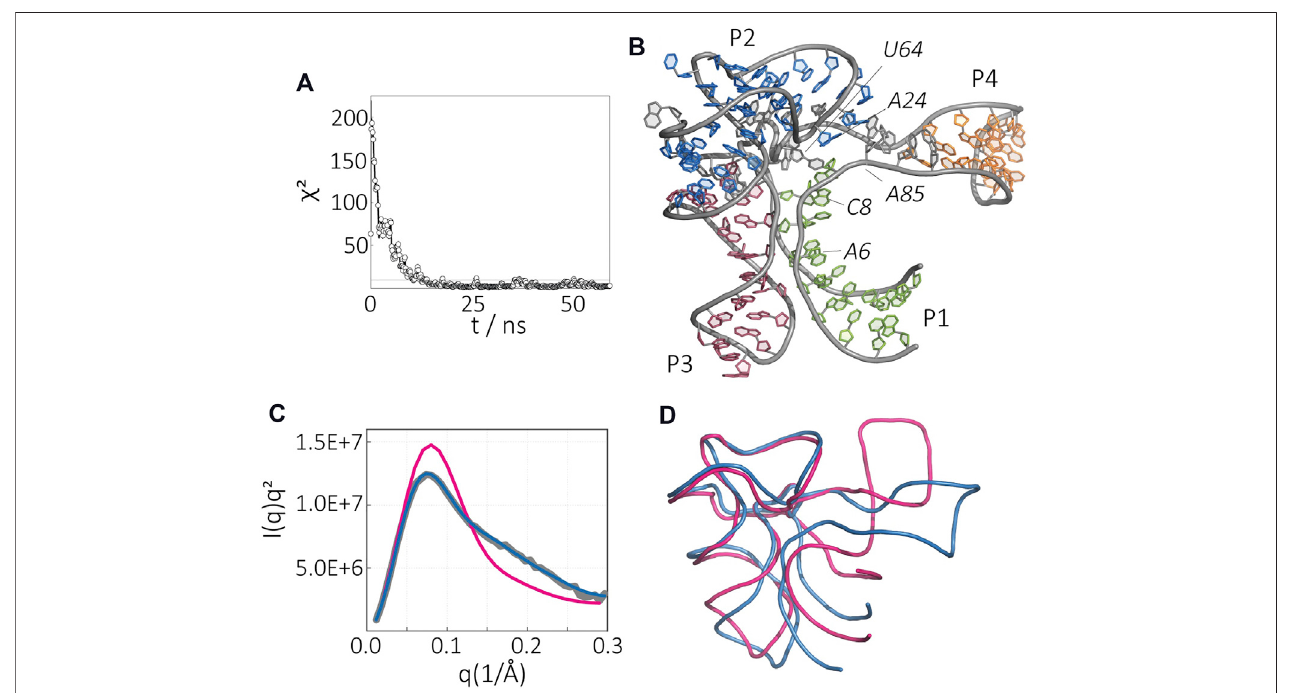
FIGURE 4 | Apo-state of the SAM-I riboswitch aptamer in the presence of Mg 2+ . (A) Time evolution of χ 2 variable during simulation. (B) The fi nal structure from SAXS-drivenMD. (C) Kratkyplotrepresentationofthemolecule,experimental SAXSdata(gray),computedSAXSdataofthecrystalstructure (magenta), andcomputed SAXS dataoftheSAXS-driven MDstructure (blue). (D) Comparison oftheSAXS-drivenMD structure (blue)and theMg 2+ -,andSAM-bound crystalstructure (magenta).